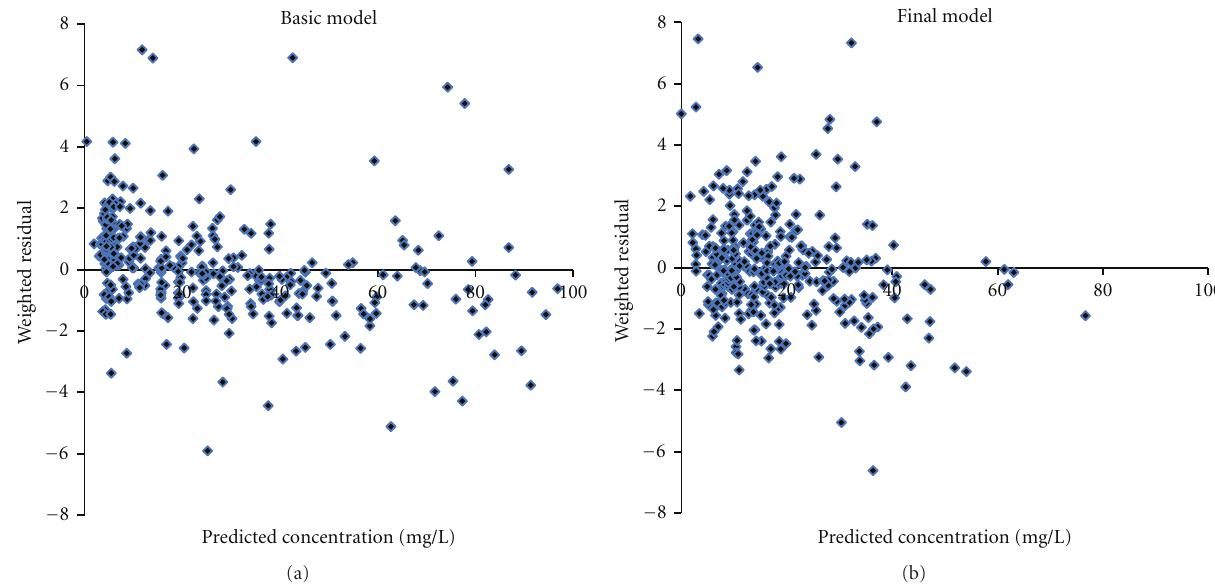
Figure 3: Scatter plot of predicted concentrations against weighted residuals in modeling group obtained from basic model (two- compartment model, without covariate) and final model (two-compartment model, with covariates).